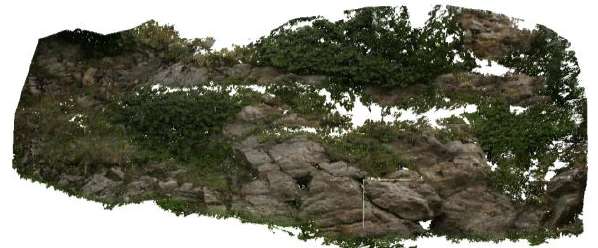
Figure 5. Agisoft PhotoScan Canon5D dense point cloud